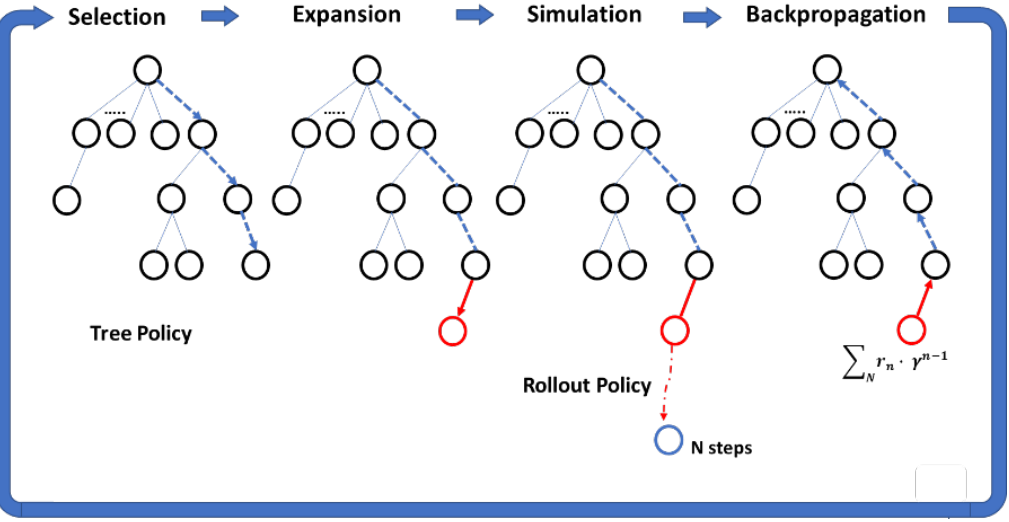
Figure 3. Schematic overview of Monte Carlo tree search algorithm phases (modified from [44]).